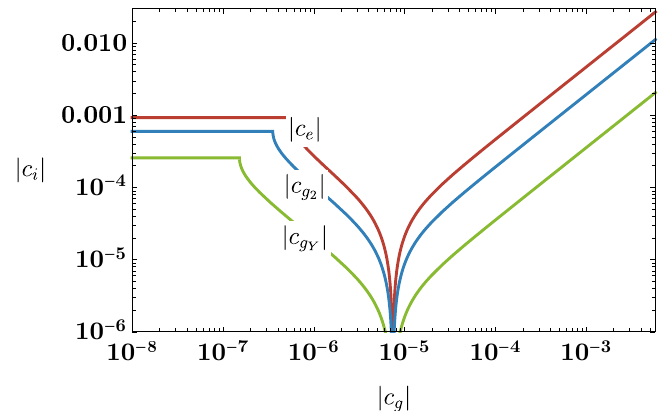
Figure 6 . Constraints from EP-violation searches from the E(cid:127)ot-Wash experiment [89] on c e , c g and c g (blue, red, yellow) as a function of j c g j , which is allowed to vary up to its maximum of p 2 j c g j (cid:24) 10 (cid:0) 5 as discussed in the text. The discontinuity at small values of j c g j corresponds to when the strongest constraint is on Im( c i ) as opposed to Re( c i